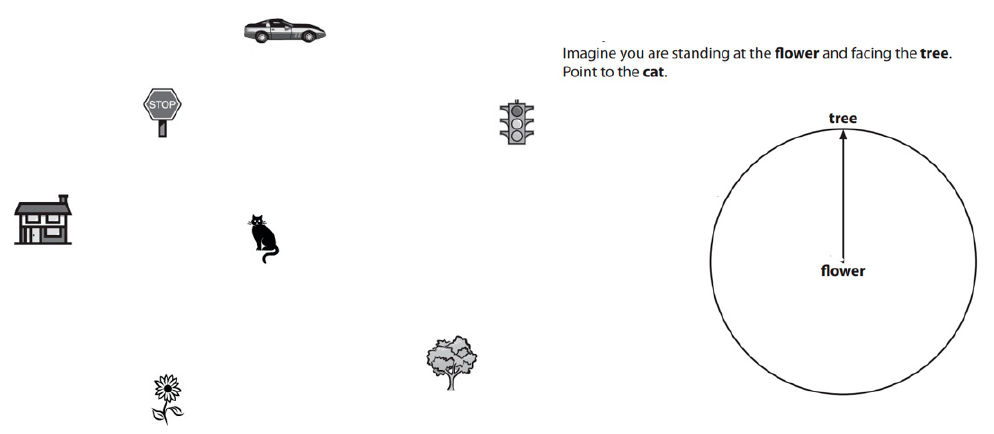
Figure 5. Example item in the Perspective Taking/Spatial Orientation Test (SOT).